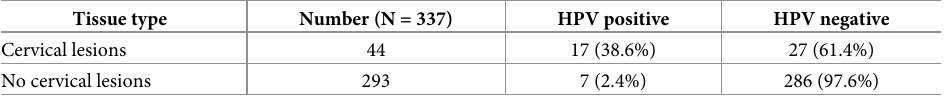
Table 4. Prevalence of HPV (16/18) infections among participant women (n = 337) aged 21–49 years, with and without cervical lesions, Amhara region, Ethiopia, 2019.